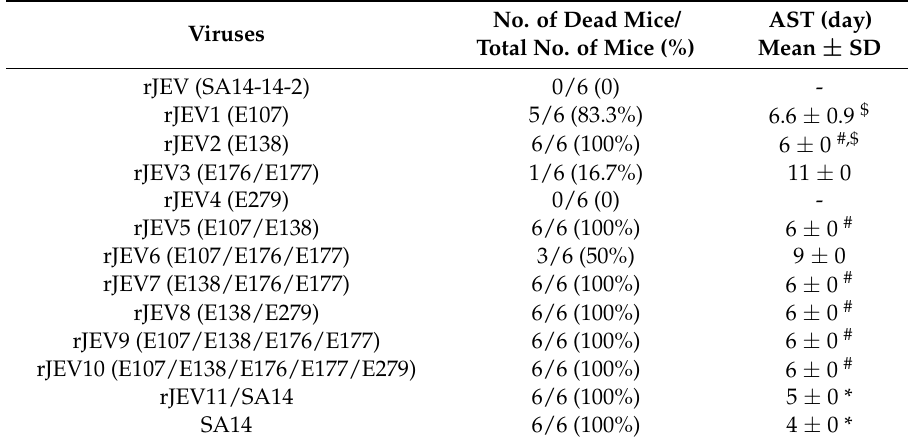
Table 3. AST and mortality of mice inoculated with the viruses by the i.c. route. No. of Dead Mice/ Viruses Total No. of Mice (%)